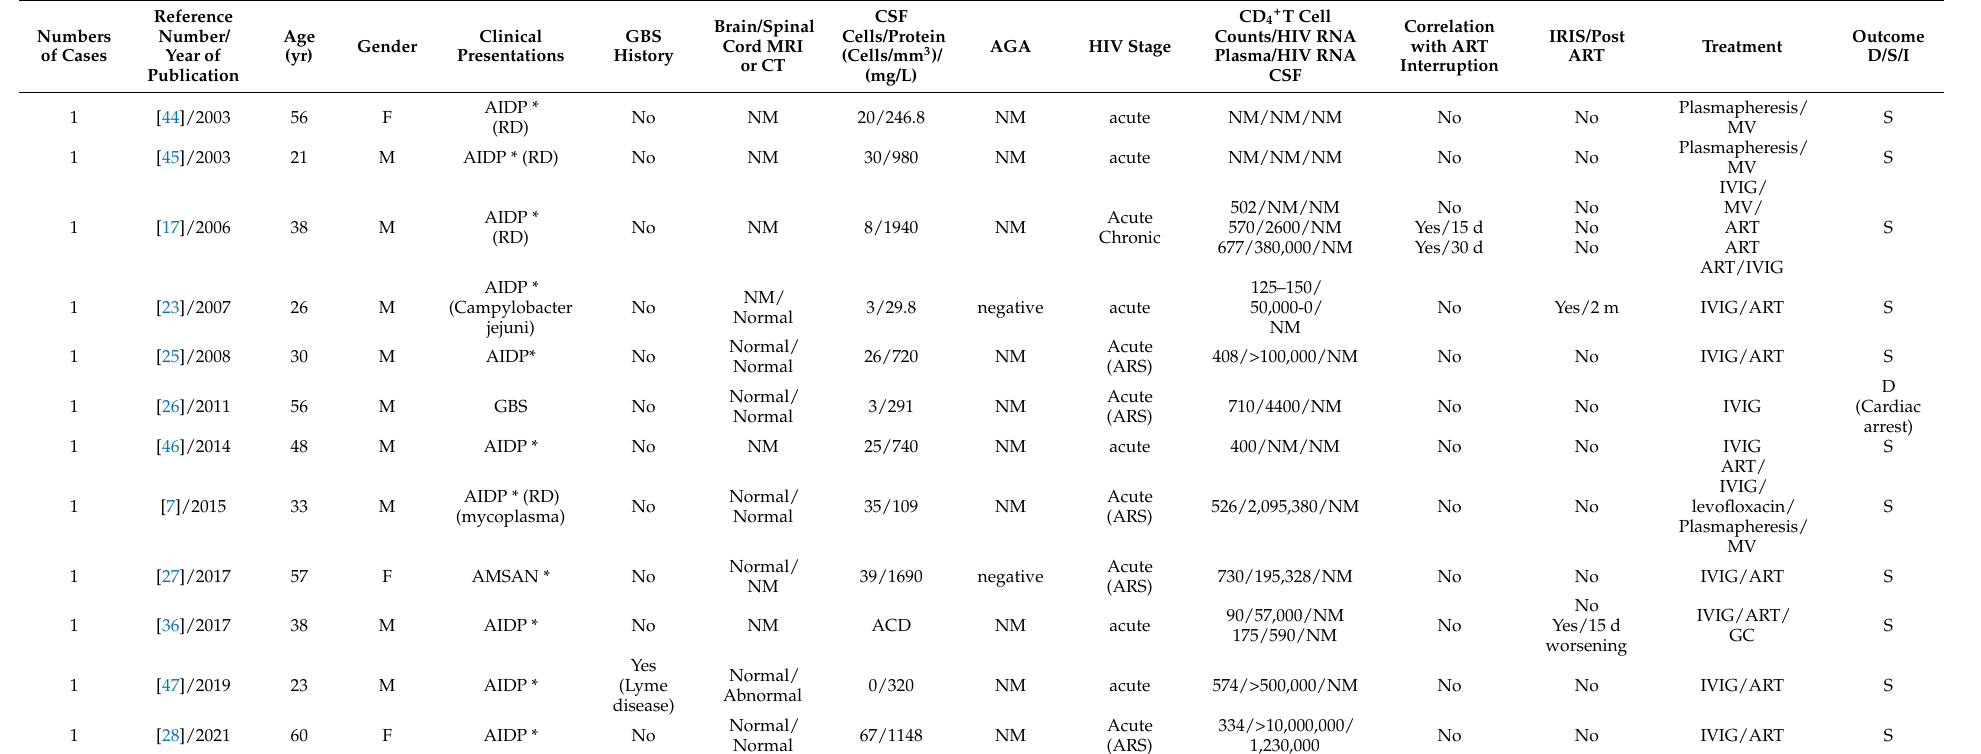
Table 1. The primary HIV-infected cases with